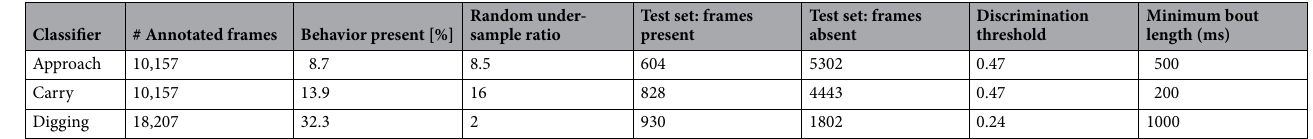
Table 1. Summary statistics on data used for behavioral classification.